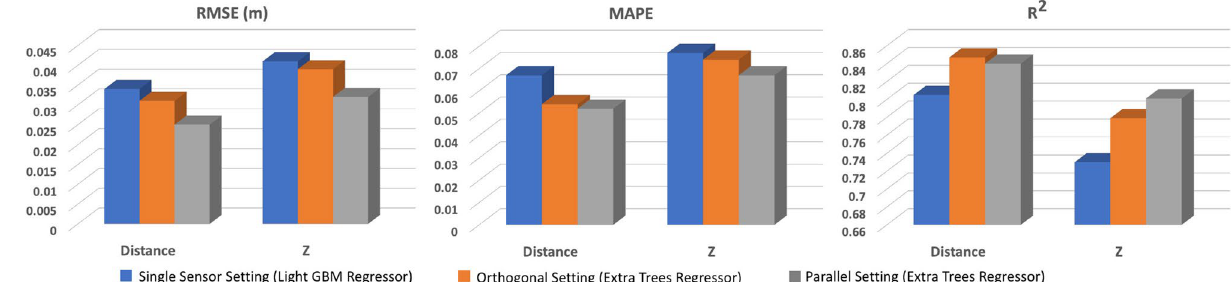
Figure 3. Performance on measured data. Results of motion tracking methods in the 3D space domain using real-world data for different settings.